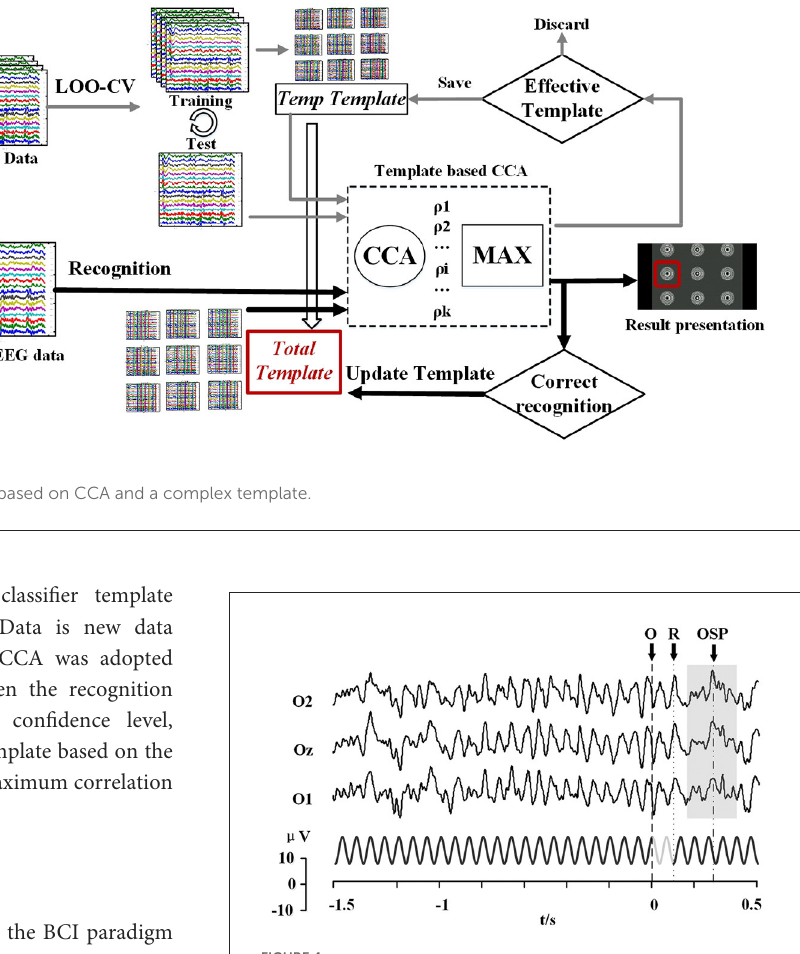
FIGURE4 Stimulus sequence of the stimulator and the typical occipital EEG responses to the missing event on SSMVEP stimuli (64 trials). The moment at arrow “O” denotes the SSMVEP stimuli omitting, while the arrow “R” denotes the stimuli’s reappearance. Gray blocks presented the primary OSP